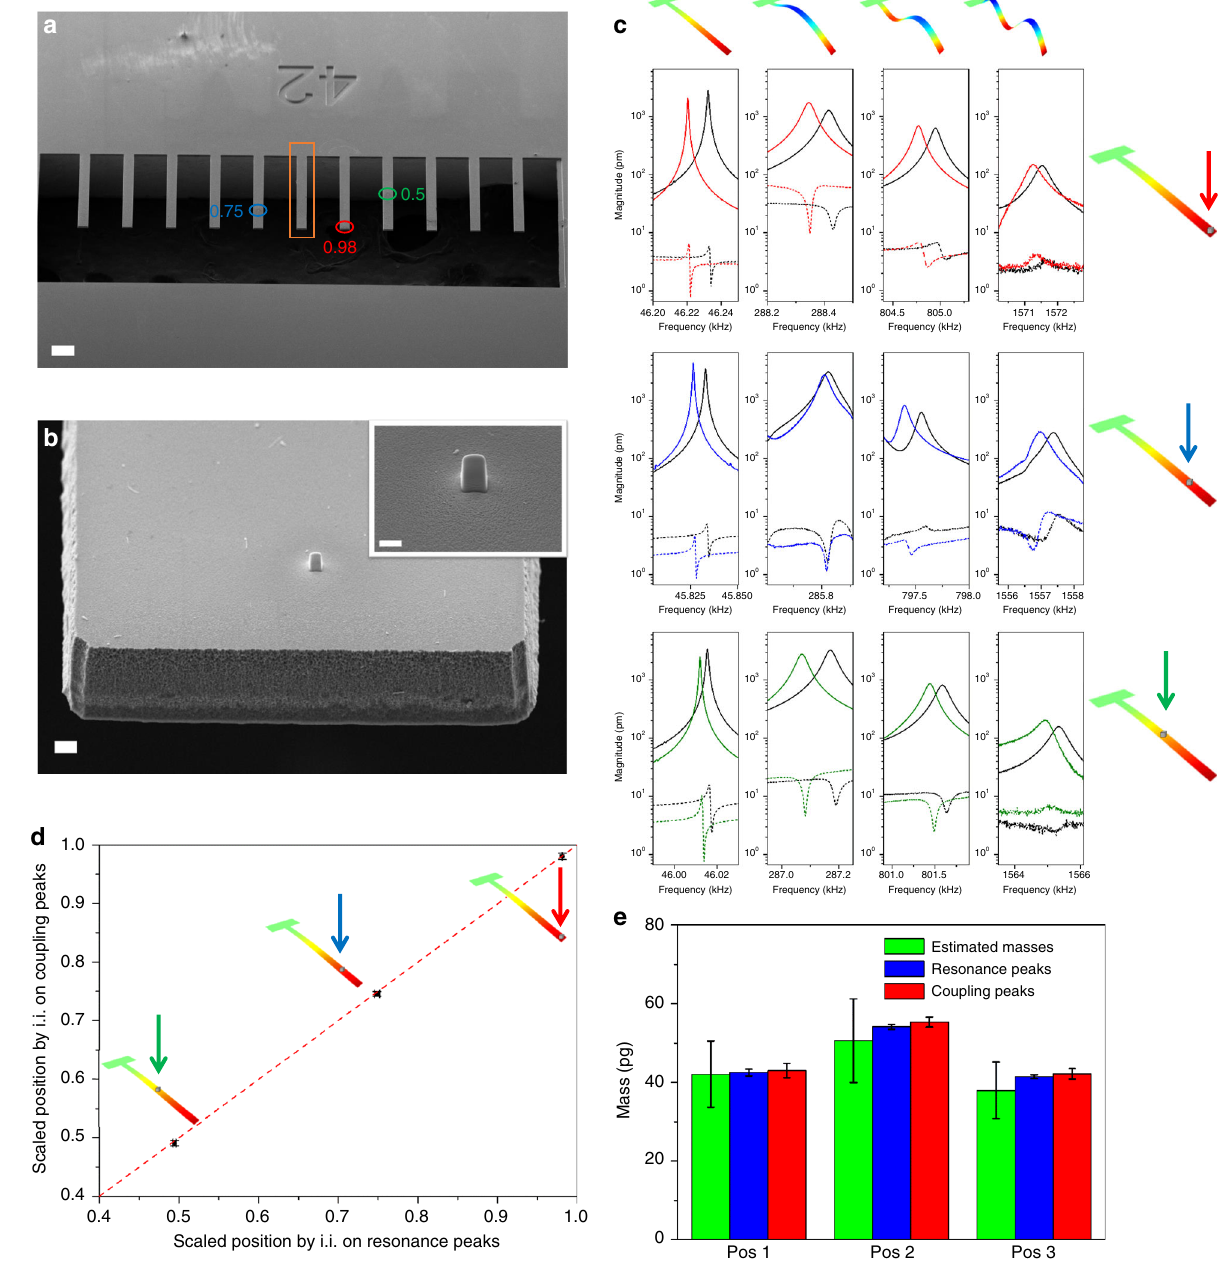
Fig. 4 Inertial imaging of adsorbed masses. a SEM image of the resonator array used. The positions of the three deposited masses are underlined with an elliptical sign, while the cantilever in the box is the resonator used for the weak-coupling peak measurement. The scale bar is 100 µ m. b Details of one of the deposited mass. The scale bars are 2 µ m in the image and 1 µ m in the inset. c Comparison of the resonance peaks and coupling peaks for the fi rst four CECs. Solid curves are the vibrational responses of the resonators with the deposited masses (Pos1 in the top graph, Pos2 in the center, and Pos3 in the bottom), while the dotted line is the response of the resonator in the central position of the array. d Position of the deposited mass determined with inertial imaging using the primary Lorentzian peak shifts and the average weak-coupling peak shifts. The error bars are determined by the fi tting residuals and frequency noise. e Masses estimated by SEM and with inertial imaging from the primary Lorentzian and weak-coupling peak